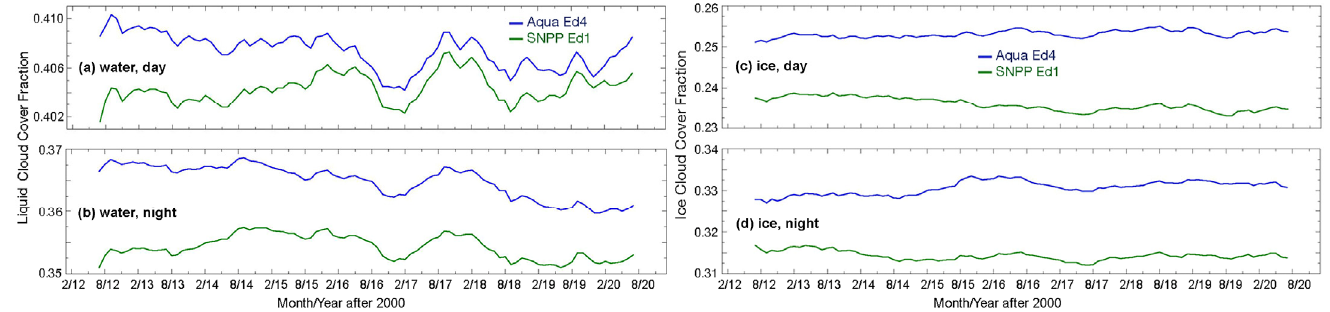
Figure 6. Global 12-month running mean liquid water ( left ) and ice ( right ) cloud fractions of total cloud amount from CM4A (blue) and CV1S (green). Table 3. Same as Table 2, except for the liquid water cloud amount.